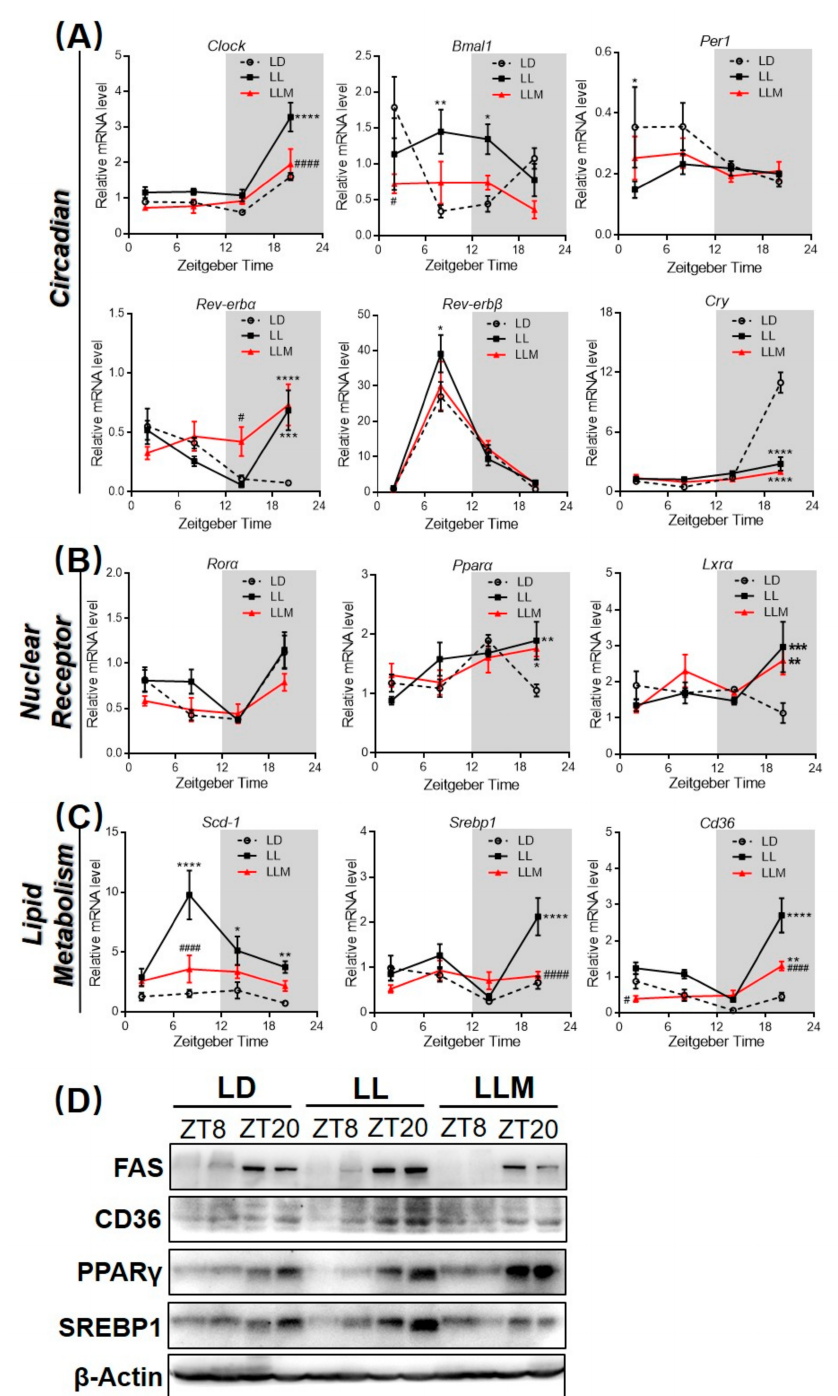
Figure 4. Constant light changes the rhythm patterns of clock genes and lipid metabolism transcripts. ( A ) The diurnal expression of various clock genes ( Clock , Bmal1 , Per1 , Rev-erb α , Rev-erb β , and Cry ) was measured in the liver. ( B ) The diurnal expression of nuclear receptors ( Ror α , Ppar α , and Lxr α ) was measured in the liver. ( C ) Transcripts involved in lipid metabolism ( Scd-1 , Srebp1 , and Cd36 ) were measured in the liver. ( D ) The liver FAS, CD36, PPAR γ , and SREBP1 protein production were examined by western blotting. Values are presented as the mean ± SEM. * p < 0.05; ** p < 0.01; *** p < 0.001 compared with LD, # p < 0.05; ## p < 0.01; ### p < 0.001 compared with LL by RM two-way ANOVA ( A – C , N =